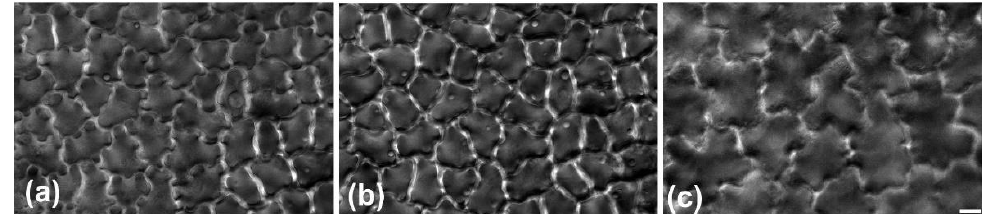
Figure 2. DIC micrographs of an adaxial epidermis area at paradermal view. ( a , b ): External epi- dermal layer at surface ( a ) and median ( b ) plane of focus. Note the diminishing of waviness in ( b ). ( c ) Hypodermis just beneath the cells depicted in ( a , b ); hypodermal cells are larger than the overlying epidermal ones. Their shape is not related to that of the overlying epidermal cells. Scale bar: 10 μm.